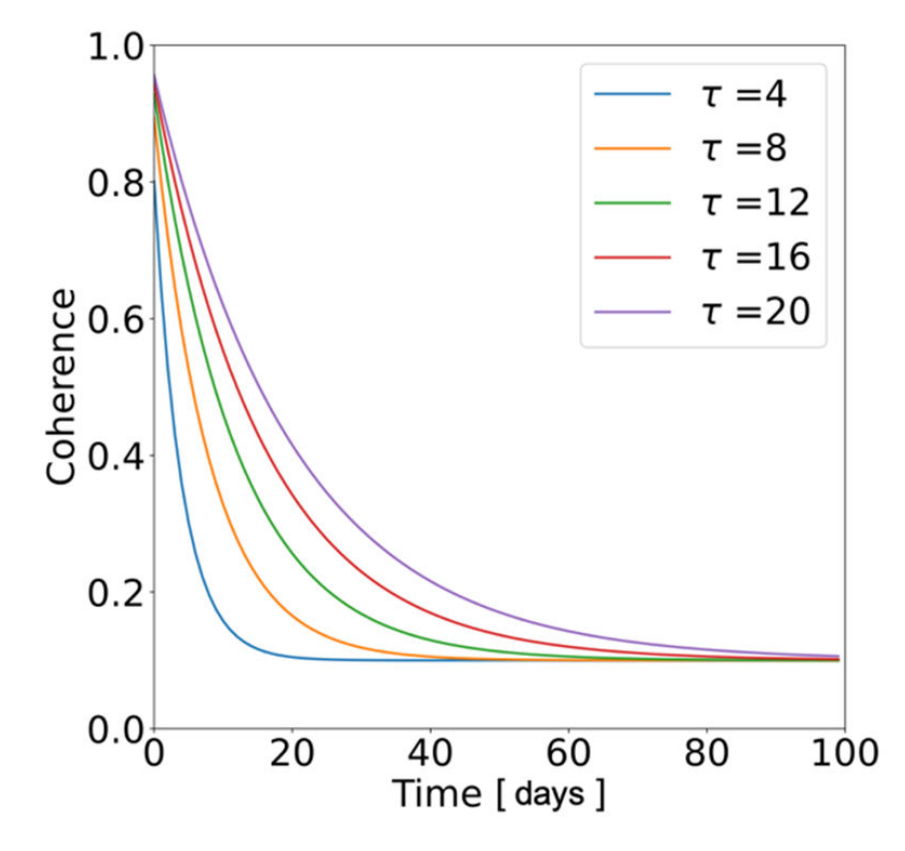
Figure 7. Temporal decorrelation model employed in the simulation. τ is varied from 4 to 20 with γ ∞ = 0.1 .